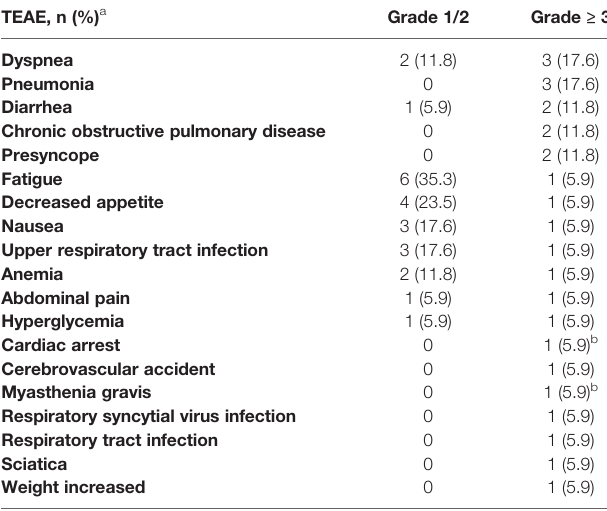
TABLE 2 | Safety (n = 17; safety population).